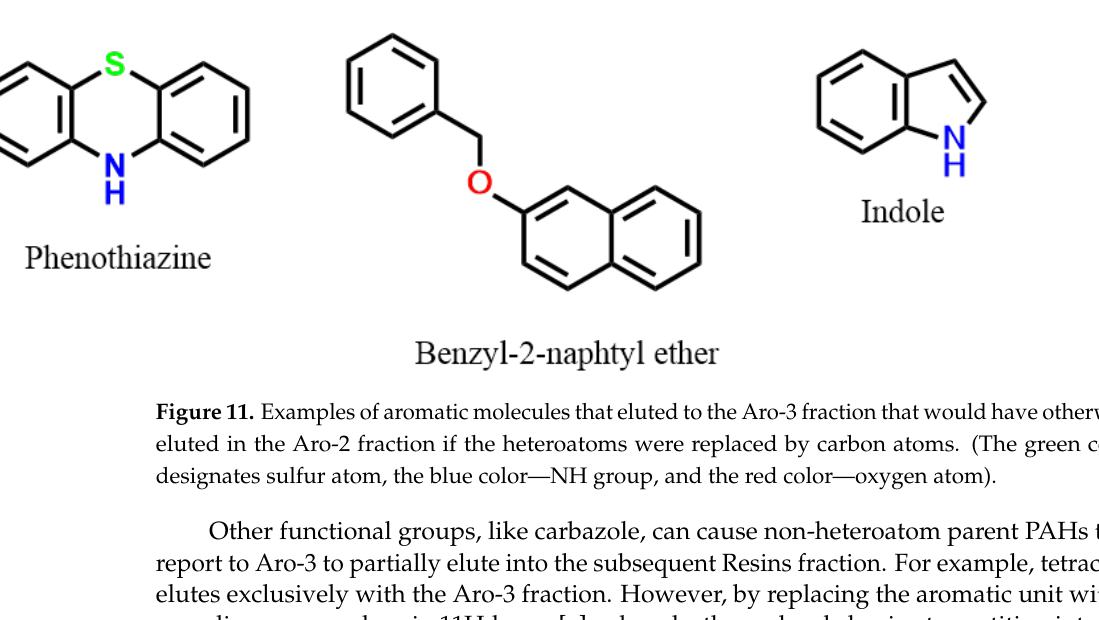
Figure 10. Aromatic molecules with bridging C al -C al linkages 1,3-di-(1pyrenyl) propane, which is linked by an aliphatic propyl group. This molecule eluted in the Aro-3 fraction.